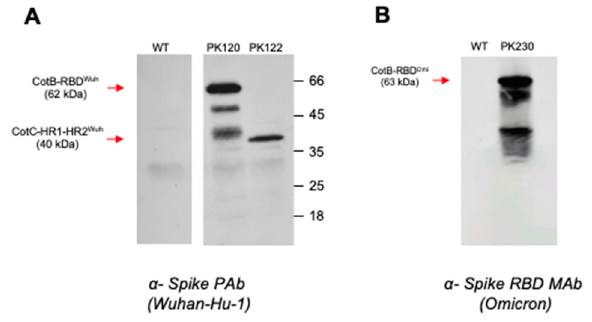
Figure 1. Spore coat expression of SARS-CoV-2 proteins. Panel ( A ) PK120 ( thyA::cotB-RBD Wuh ) and PK122 ( thyA::cotC-HR1-HR2 Wuh ) express the RBD and HR1-HR2 domains of Spike from the Wuhan-Hu-1 (2019-nCoV) variant when probed with anti-S (Wuhan-Hu-1) PAbs. Bands corresponding to CotB-RBD Wuh (62 kDa) and CotC-HR1-HR2 Wuh (40 kDa) are shown. No bands were detectable in spores of the isogenic strain WT which expresses no heterologous antigens. Panel ( B ) PK230 ( thyA::cotB-RBD Omi ) expresses the RBD domain of Omicron (B.1.1.529) fused to CotB (63 kDa) when probed with anti-S (Omicron) PAbs. No bands were detectable in spores of the strain